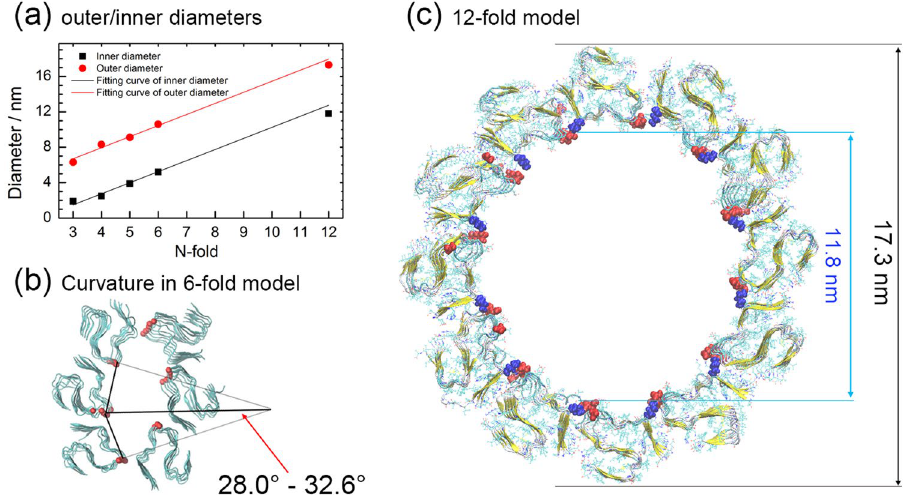
Figure 8. Outer and inner diameters. ( a ) The outer and inner diameters of N-fold models and the corresponding fit as function of fold number. ( b ) Curvature of the adjacent fold component in the six-fold model. ( c ) The final confirmation of the 12-fold model after 50 ns of molecular dynamics simulation, and its inner and its outer diameters.